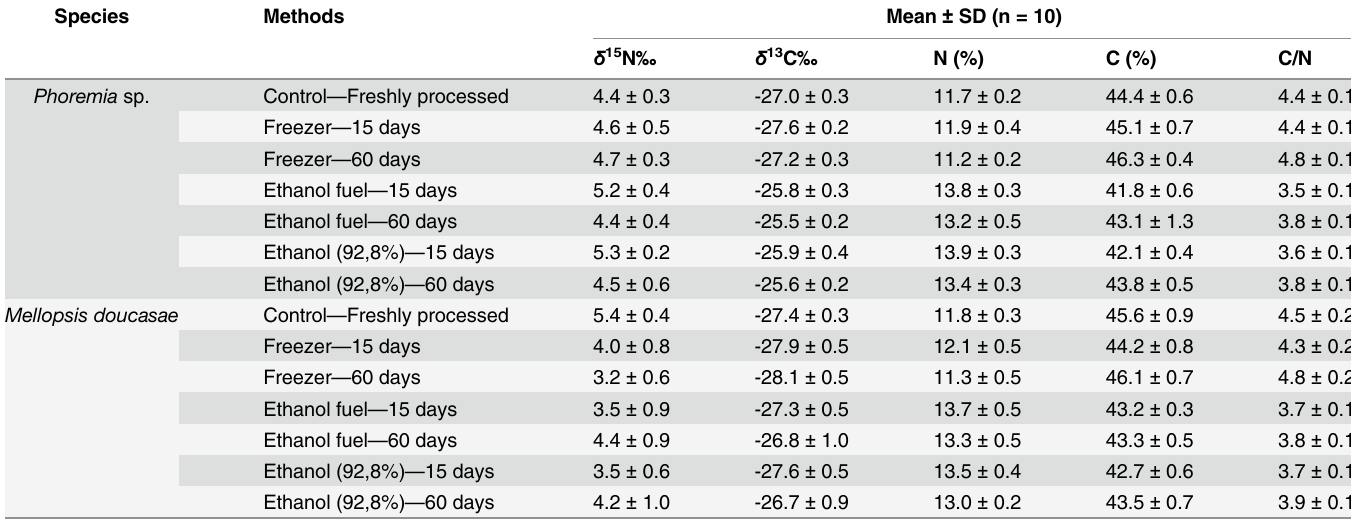
Table 1. Carbon and nitrogen stable isotope values, N(%), C(%) and C/N atomic values. Mean ± SD for δ 15 N, δ 13 C isotopic values, nitrogen and carbon total content (%), and C/N atomic values of cricket samples subjected to different preservation methods. Species